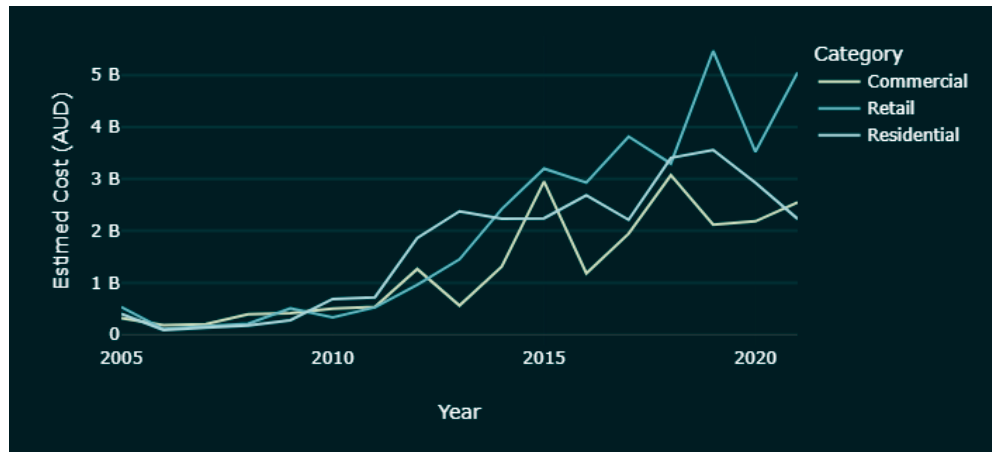
Figure 35. Total estimated cost of approved DAs by proposed uses over time (2005–2021).